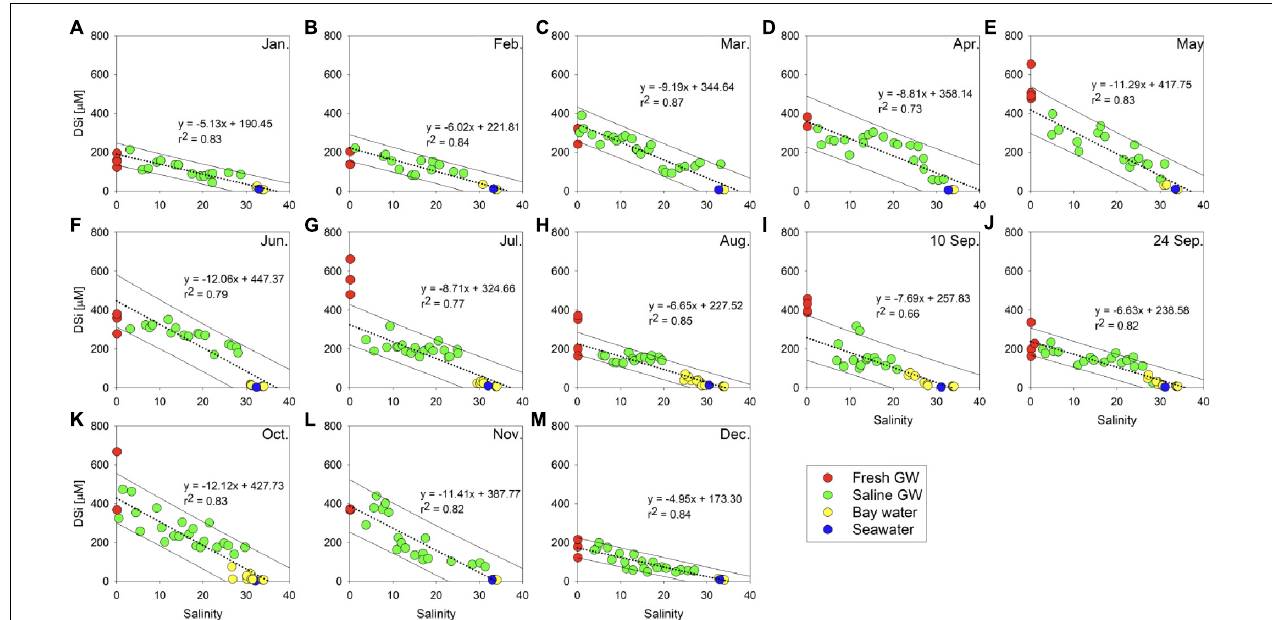
FIGURE 2 | Scatter plots between dissolved silicon (DSi) and salinity in each sampling campaign. The dotted lines indicate the regression lines for the saline groundwater, bay water, and seawater. The solid lines indicate the boundaries of the 95% prediction intervals for the